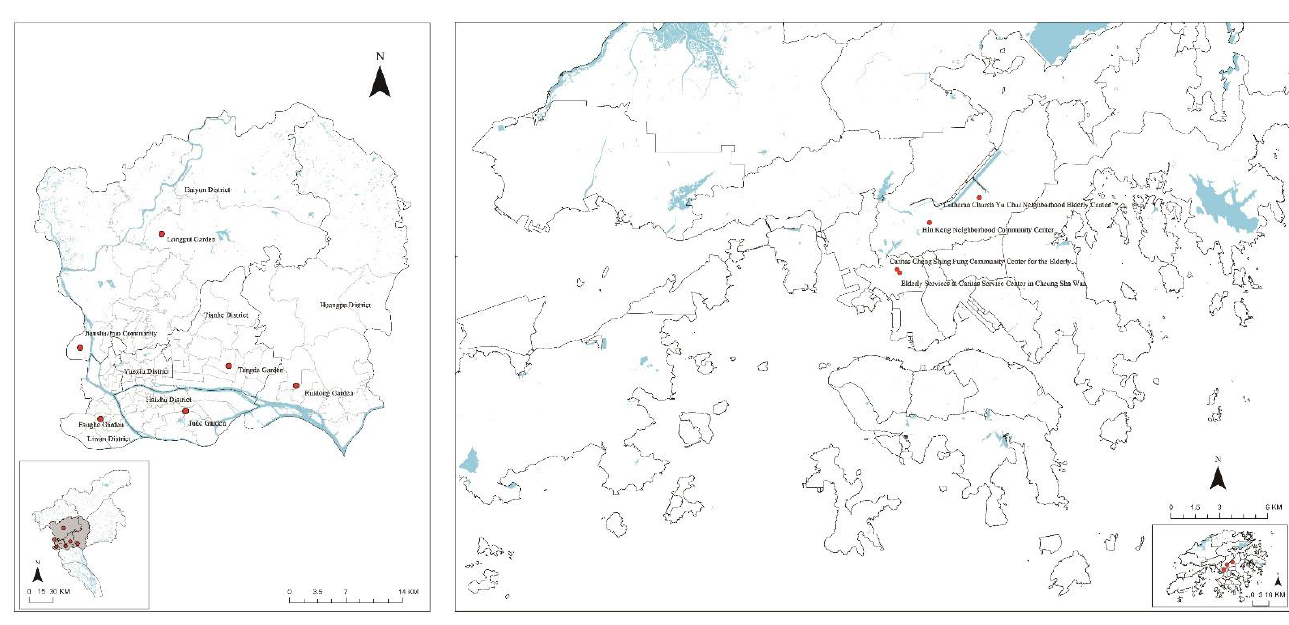
Figure 2. Location of the study area.